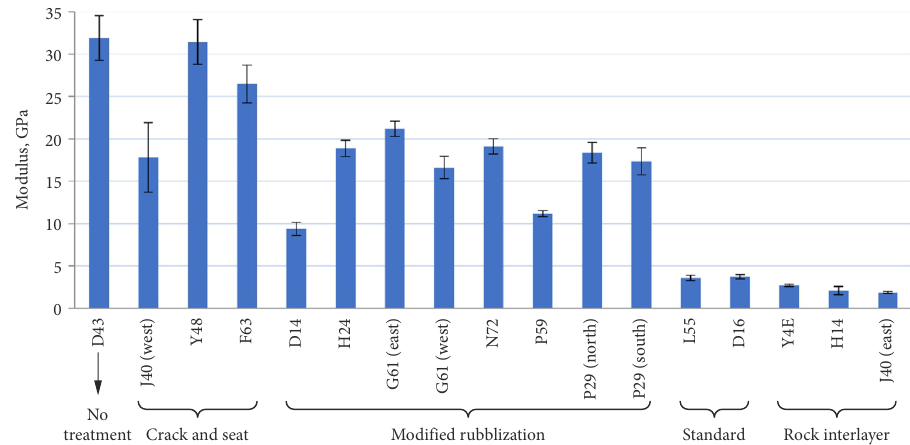
Figure 4. Mean modulus and standard error of the untreated/treated layers for each